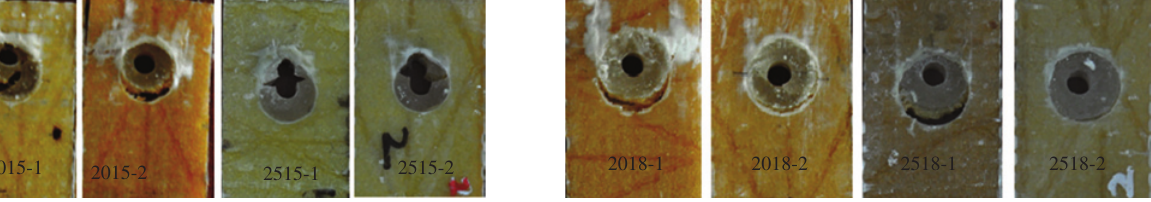
Figure 14 Images of the damaged samples of configurations E = 20 and 25 mm and D = 18 mm.